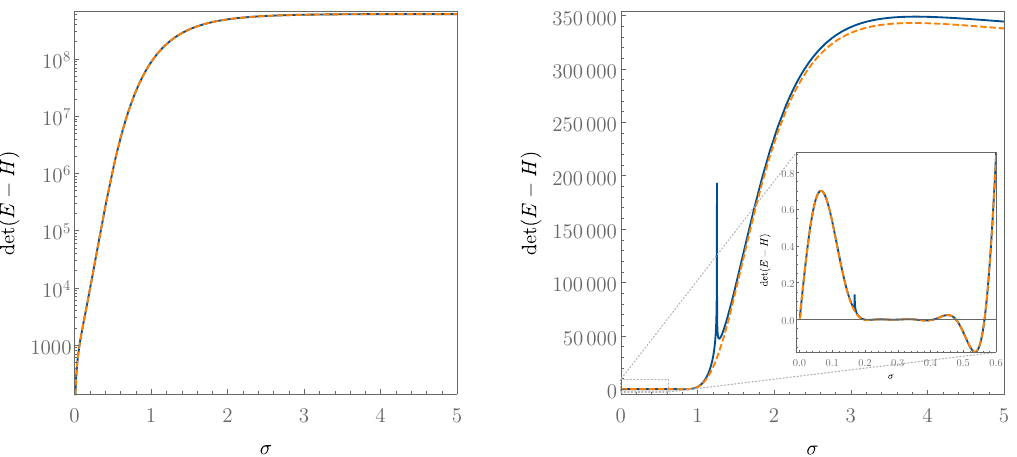
Figure 16: Comparison between numerical evaluation of (56) (orange dashed) and its saddle point approximation (solid blue) at L “ 20, taking only the saddles men- tioned in the text into account. We used b “ 2 and z “ 5 { 2. The plot on the left is a log plot (because the range is rather big) for E “ 3 which remains outside any cut as a function of σ , and we see that the saddle point approximation is excellent. For the right figure we have E “ 2.2 and will thus enter and leave a cut as σ decreases. The saddle point approximation is still very good, except when the value of E enters a cut around σ « 0.16 and « 1.2. At these values for σ the saddles change dom- inance and the saddle point approximation breaks down, leading to bigger errors. Notably, between those two values there are two saddles (orange and black in Fig. 15) contributing. The inset on the right shows the same plot, but for smaller values of σ